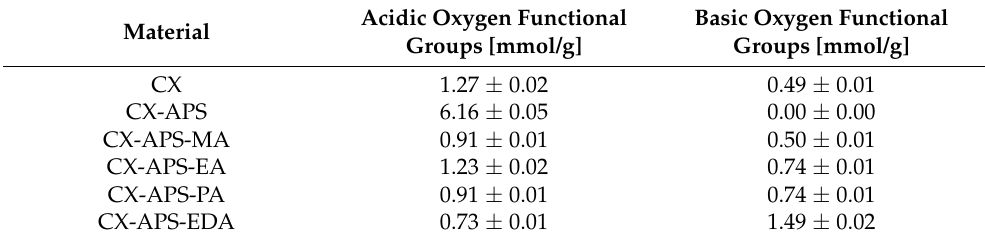
Figure 3. TG ( A ) and DTG ( B ) curves from 25 to 1000 °C of pure and amine-modified carbon xerogels registered under N 2 atmosphere. Table 3. Acid–base properties of carbon